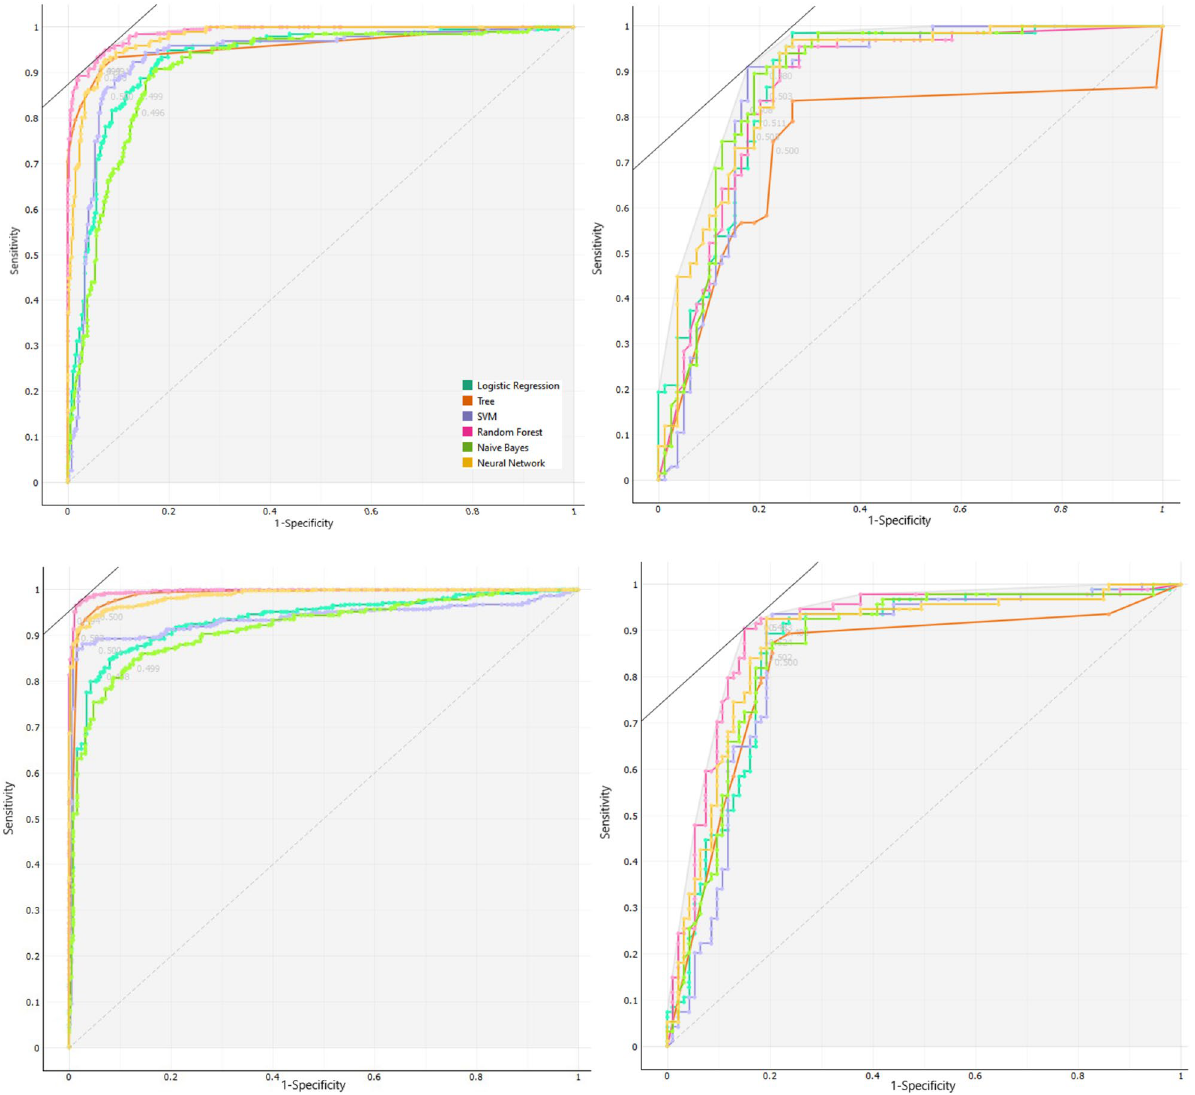
Figure 2. ROC curves for different ML algorithms for predicting metastasis in gastric cancer patients. (Top left: Train original data, Top right: Test original data, Down left: Train balanced data, Down right: Test balanced